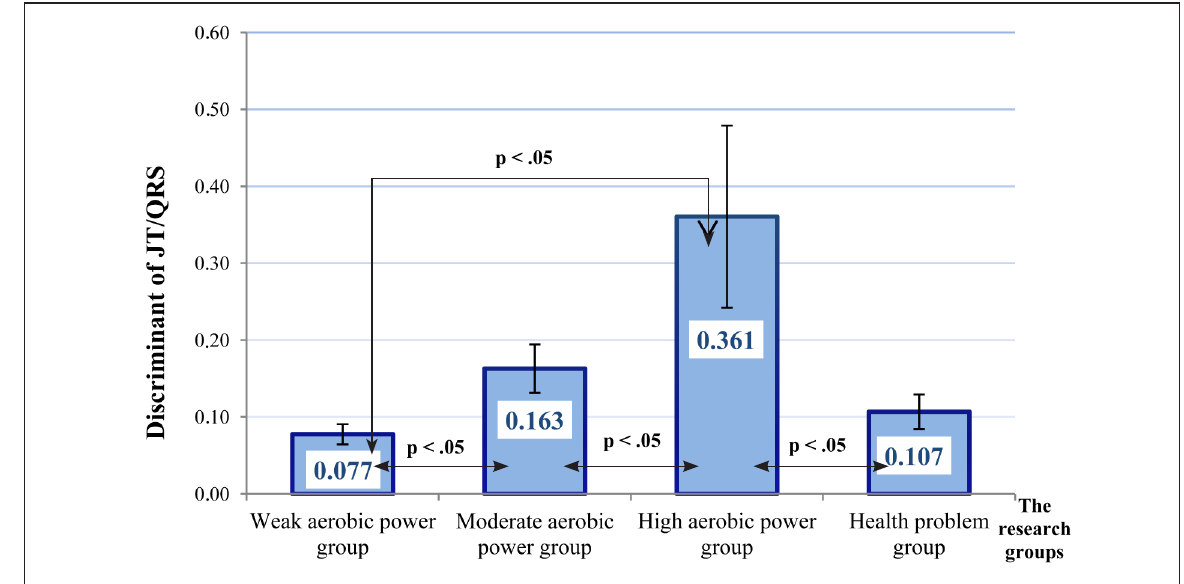
Figure 3. Discriminant of concatenation between JT and QRS parameters at the anaerobic threshold during bicycle ergometry